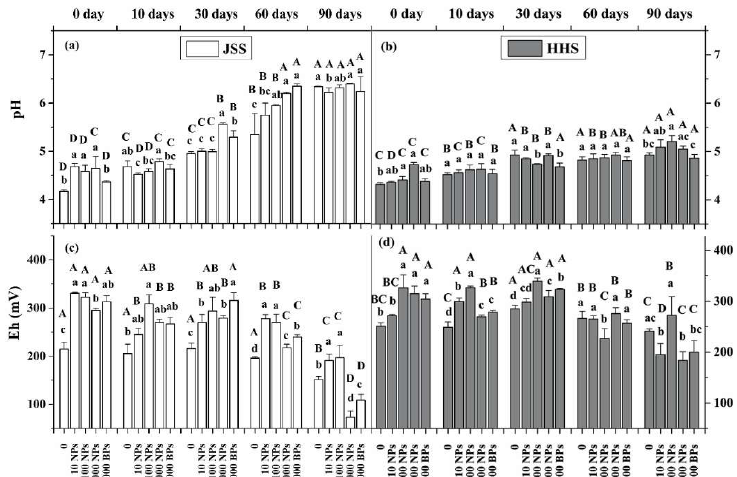
Figure 4. pH and Eh of two tested soils during flooding–drying period. White: Jinshan Soil (JSS); Gray: Heihe Soil (HHS). ( a , b ) pH; ( c , d ): Eh (mV). Error bars indicate the standard deviation of the mean ( n = 3). Lowercase letters indicate the significance between the different dose exposure treatments over the same period. Uppercase letters indicate the significance between the different time treatments of the same exposed dosage ( p <